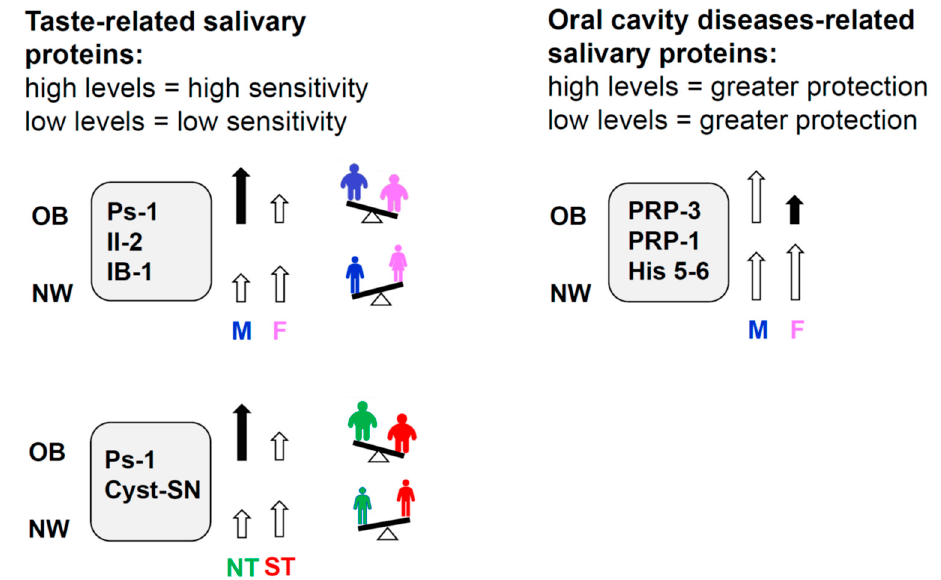
Figure 5. Picture showing a summary of findings on differences between NW and OB in salivary protein levels as a function of gender and PROP taster status. The height of arrows indicates the quantified level of proteins.